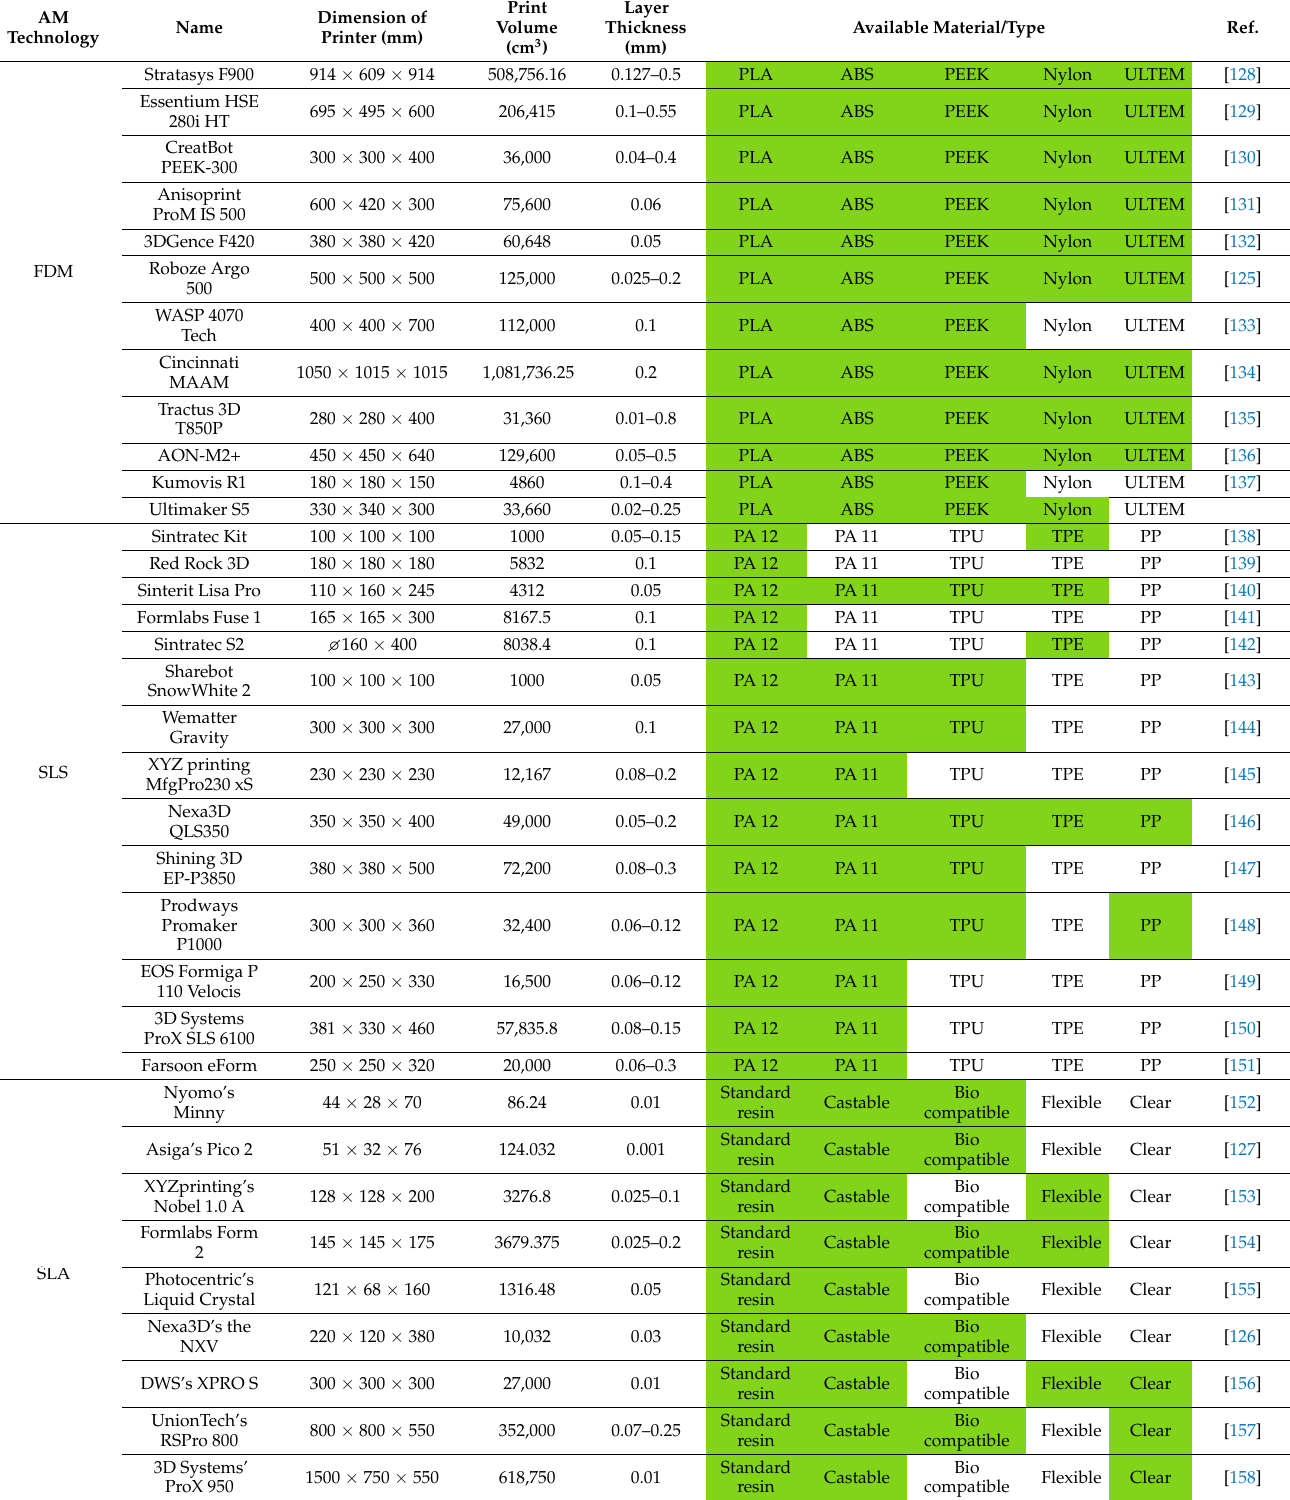
Table 1. A directory of commercially available industrial-grade FDM, SLS, and SLA 3D printers and their specifications, information is collected from the supplier’s website. The green highlight indicates the print material best suitable for the given printer according to the supplier. For SLA, the materials are categorized based on their type/specific properties as claimed by the